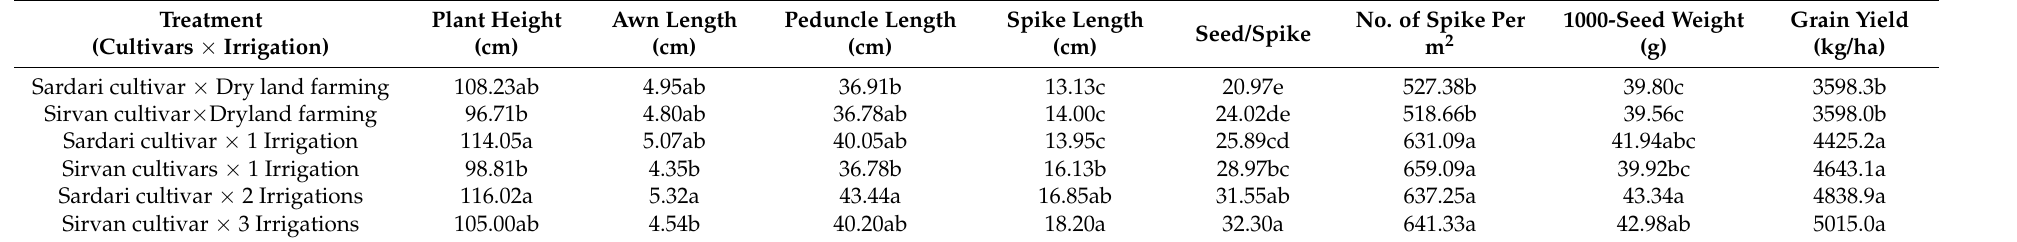
Table 4. Mean comparisons of the dual interactions of irrigation and cultivars on some